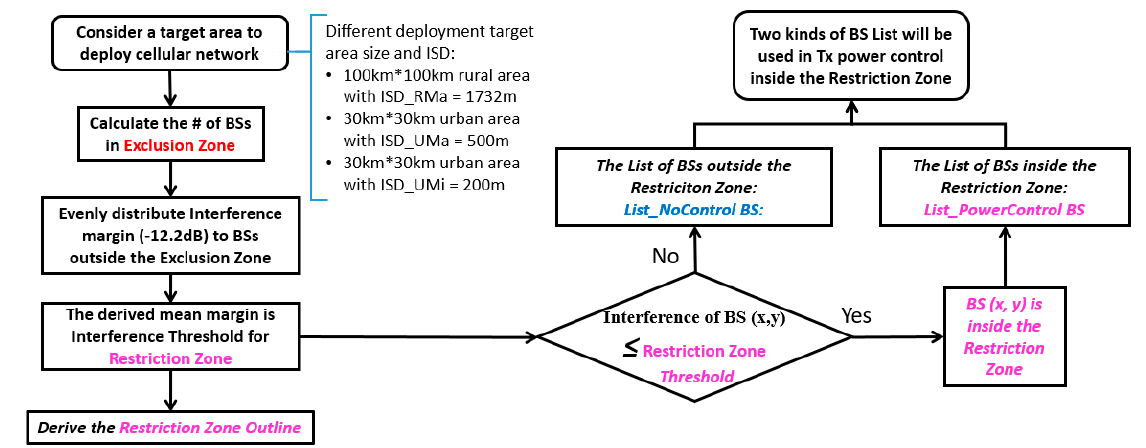
Figure 8. Flowchart for the distance protection method: Restriction zone.